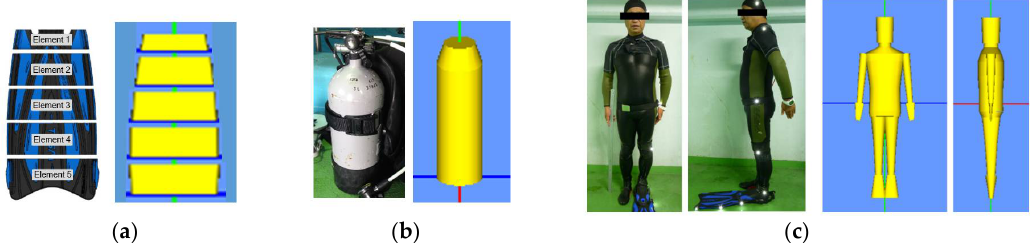
Figure 2. The shapes of the simulation model. In each figure, the left side is the photographed image and the right side is the model: ( a ) Fin model; ( b ) Tank model; ( c ) Diver model.